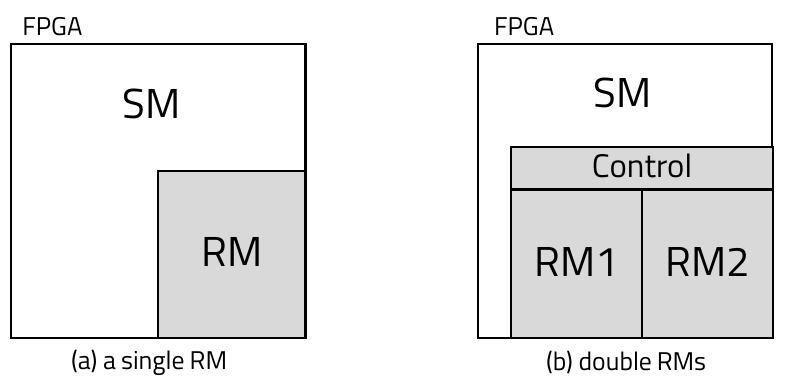
Figure 20. Experimental cases according to the number of RMs.